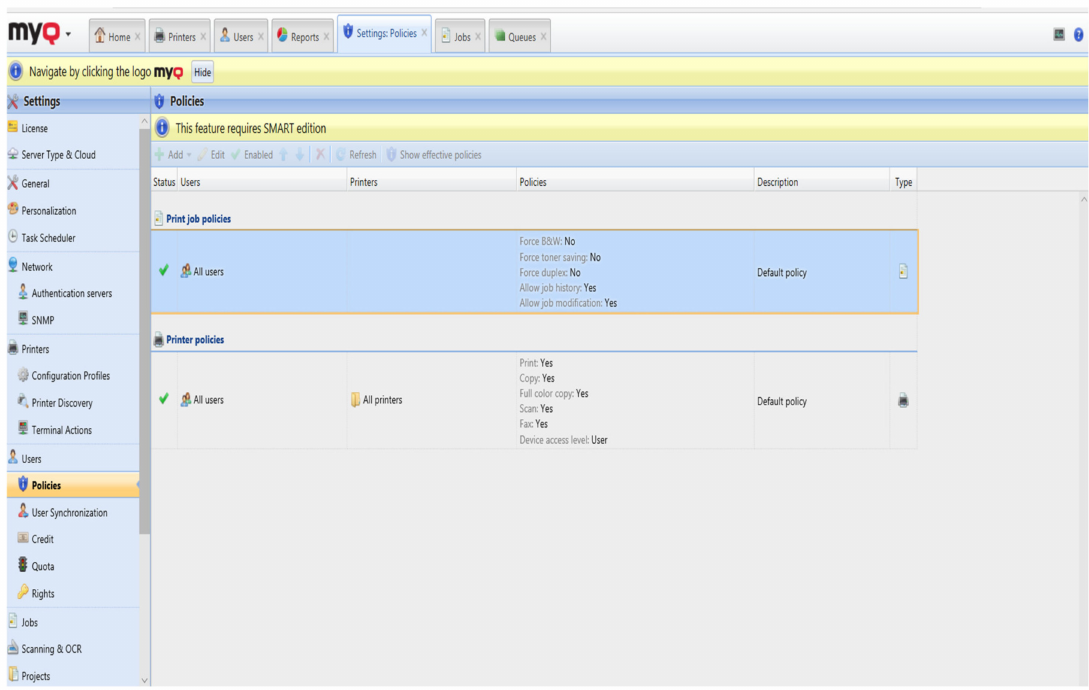
Figure 5. Basic policy settings for print jobs and printers. Source: custom